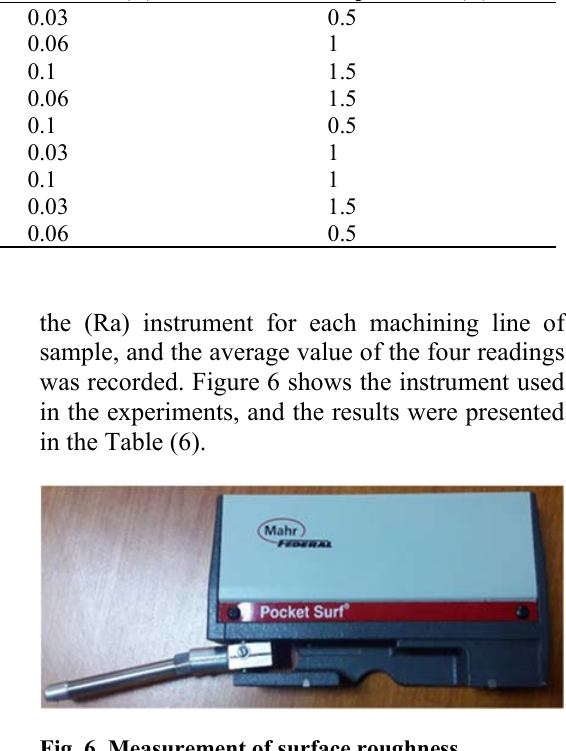
Fig. 6 . Measurement of surface